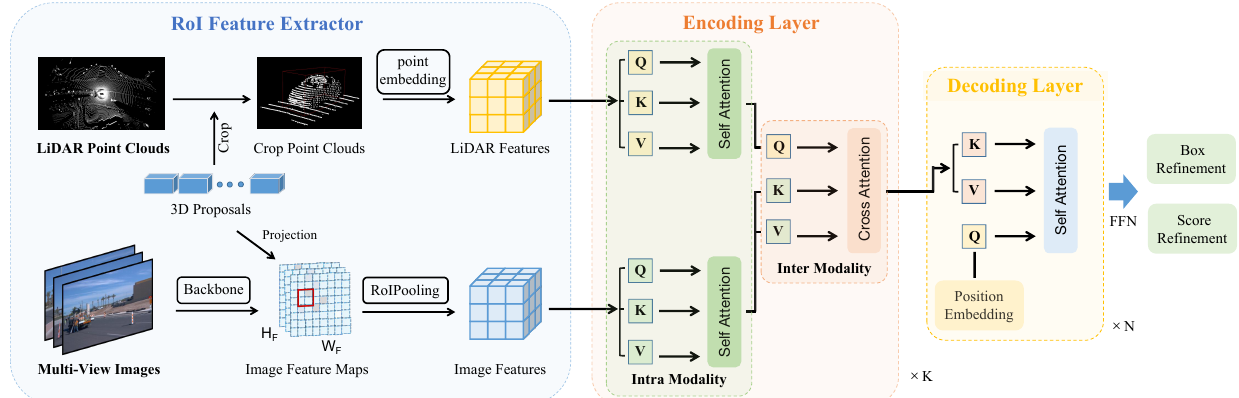
Figure 2. Overall architecture of FusionRCNN. Given 3D proposals, LiDAR and image features are extracted separately through the RoI feature extractor. Then, the features are fed into K fusion encoding layers which comprise self-attention and cross-attention modules. Finally, point features fused with image information are further fed into a decoder and predict the refined 3D bounding boxes and confidence